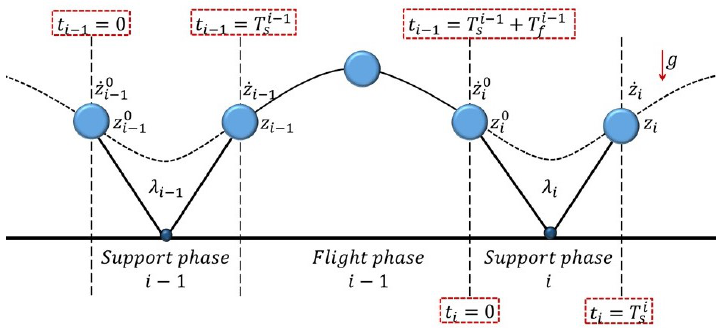
Figure 2. The motion of the COM in the vertical